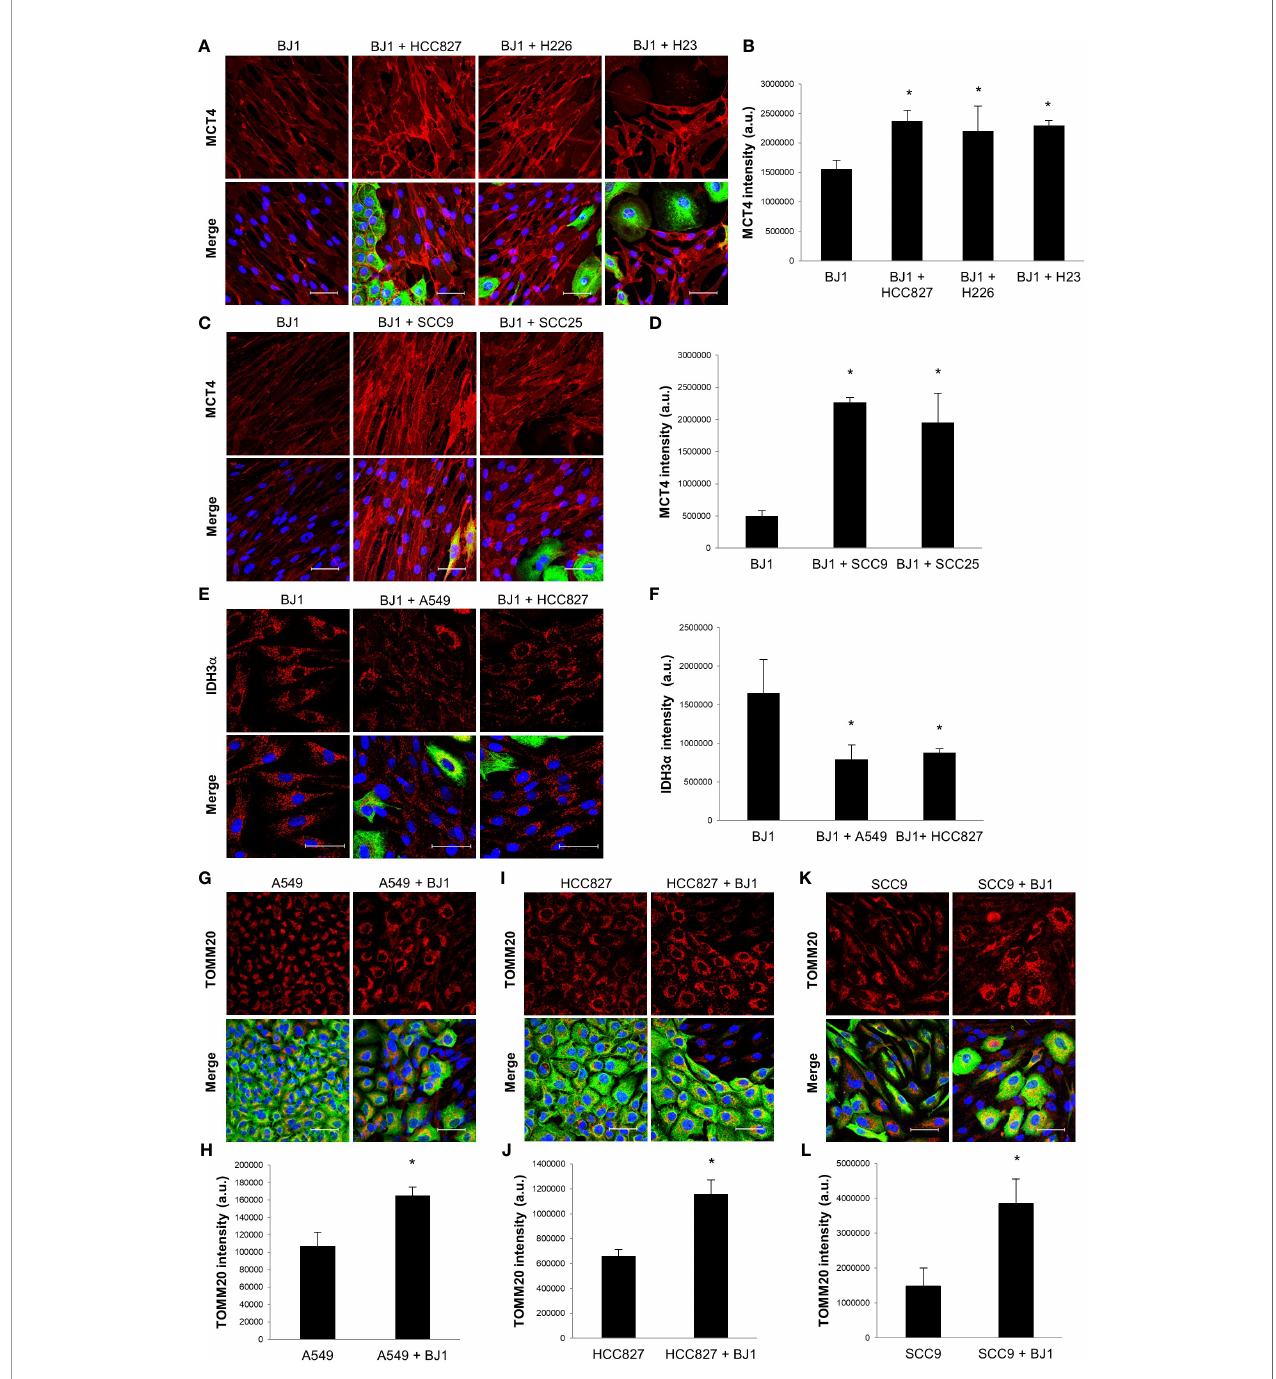
FIGURE 2 | Expression of markers of metabolic compartmentalization in co-cultures of ADT carcinoma cells and fi broblasts. Human ADT carcinoma cell lines A549, HCC827, H226, H23, SCC9 and SCC25 were co-cultured with BJ1 fi broblasts for 4 days. Monocultures of carcinoma cells and BJ1 fi broblasts were maintained in parallel as controls. (A – D) Confocal imaging of MCT4 in monocultures of BJ1 and in co-cultures of BJ1 with the NSCLC cells HCC827, H226 and H23 (A) and HNSCC cells SCC9 and SCC25 (C) , and their respective quanti fi cation of MCT4 staining in BJ1 (B, D) . (E, F) . Confocal imaging of IDH3 a in monocultures of BJ1 and in co-cultures of BJ1 with A549 and HCC827 (E) , and quanti fi cation of IDH3 a staining in BJ1 (F) . (G – L) Confocal imaging of TOMM20 in monocultures and co- cultures of A549 (G) , HCC827 (I) , and SCC9 (K) with BJ1, and quanti fi cation of TOMM20 staining in A549 (H) , HCC827 (J) and SCC9 (L) . Confocal microscopy images were acquired at the 40X magni fi cation, with 1.5x zoom in panel (E) . For all images, MCT4, IDH3 a and TOMM20 staining are shown in red, carcinoma cells are shown in green (K8/18 staining), and nuclei are shown in blue (DAPI). For all markers, red staining was quanti fi ed using ImageJ. Student ’ s t-test was used for statistical analyses (*p<0.05). (a.u., arbitrary units. Scale bar = 50 m